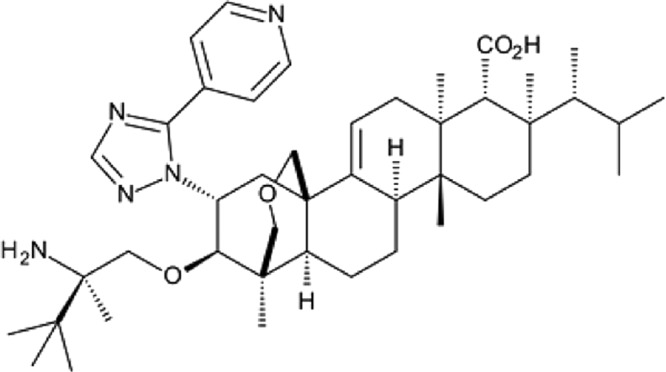
Chemical structure of SCY-078. Position 15 of the core phenanthropyran carboxylic acid ring system is modified with a pyridine triazole, and position 14 is modified with a 2-amino-2,3,3-trimethyl-butyl ether, (1S,4aR,6aS,7R,8R,10aR,10bR,12aR,14R,15R)-15-[[(2R)-2-amino-2,3,3-trimethylbutyl]oxy]-8-[(1R)-1,2-dimethylpropyl]-14-[5-(4-pyridinyl)-1H-1,2,4-triazol-1-yl]-1,6,6a,7,8,9,10,10a,10b,11,12,12a-dodecahydro-1,6a,8,10a-tetramethyl-4H-1,4a-propano-2H-phenanthro[1,2-c]pyran-7-carboxylic acid.